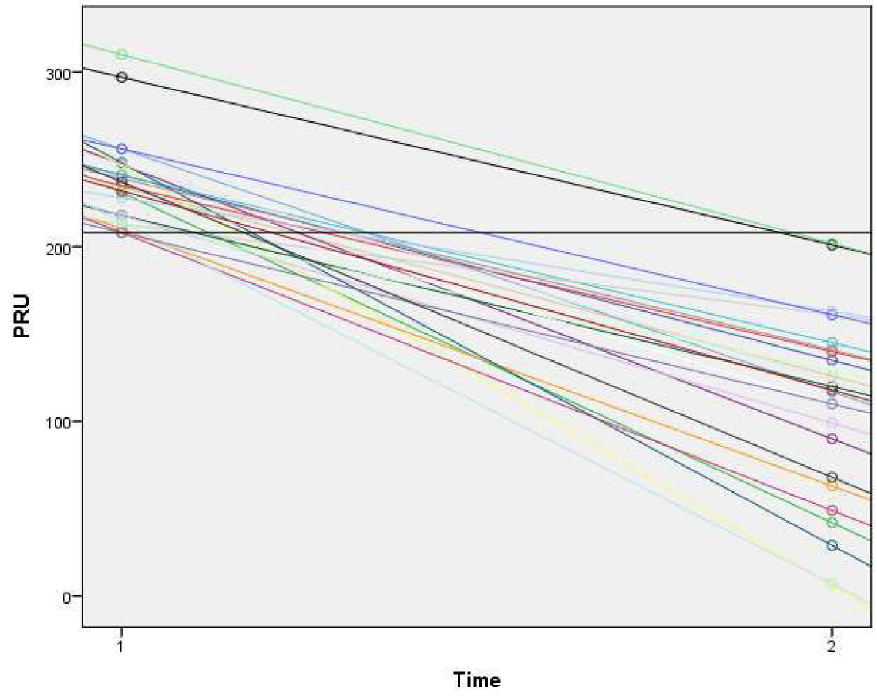
Fig 2. PRU change over time.